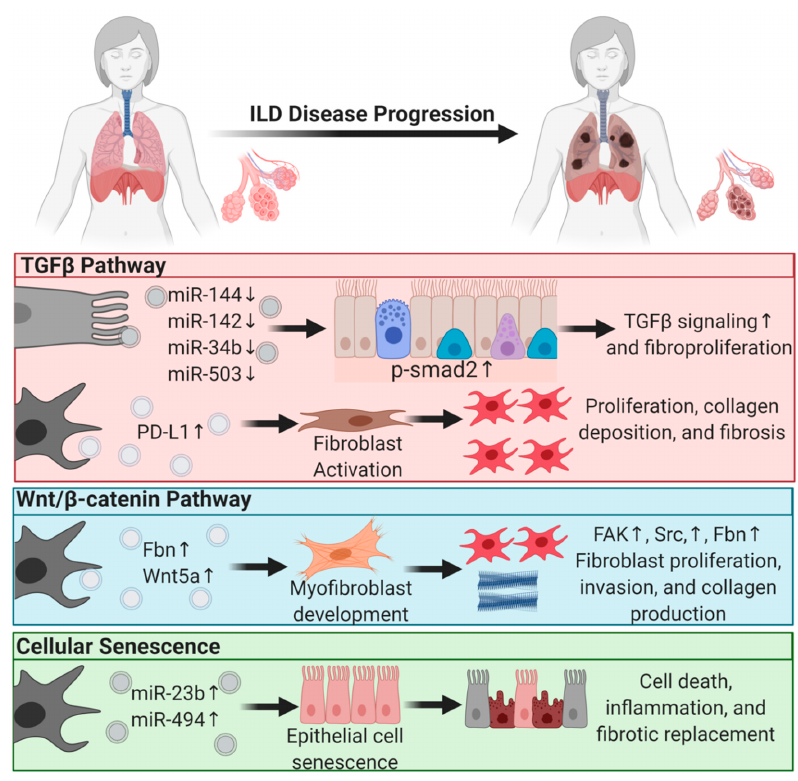
Figure 1. Extracellular vesicles regulate profibrotic signaling pathways in interstitial lung disease pathogenesis. Major profibrotic pathways are regulated by extracellular vesicles’ (EVs) cargo molecules in driving the principal pathways of lung fibroproliferative diseases. Arrows pointing up reflect upregulation and arrows pointing down signify downregulation.